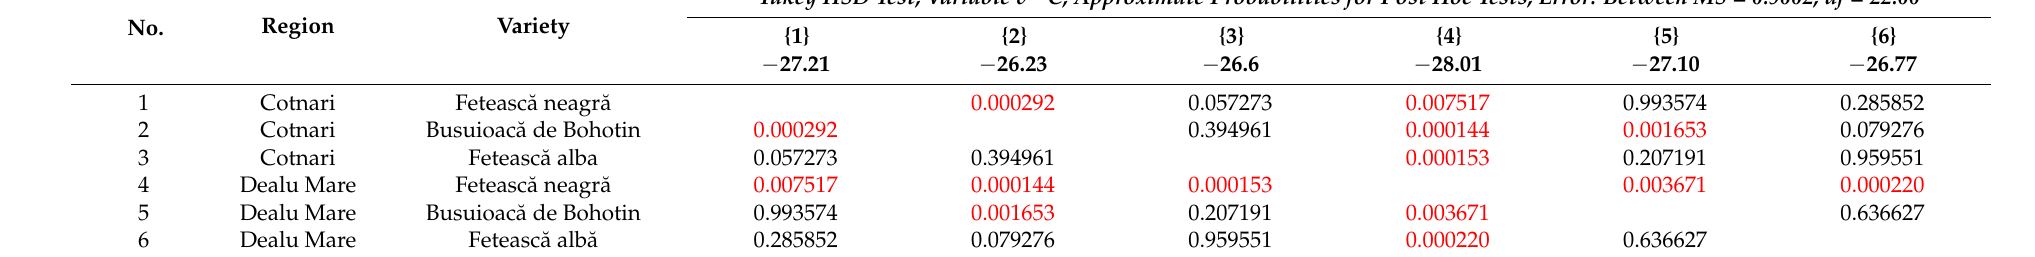
Table 7. Tukey HSD test